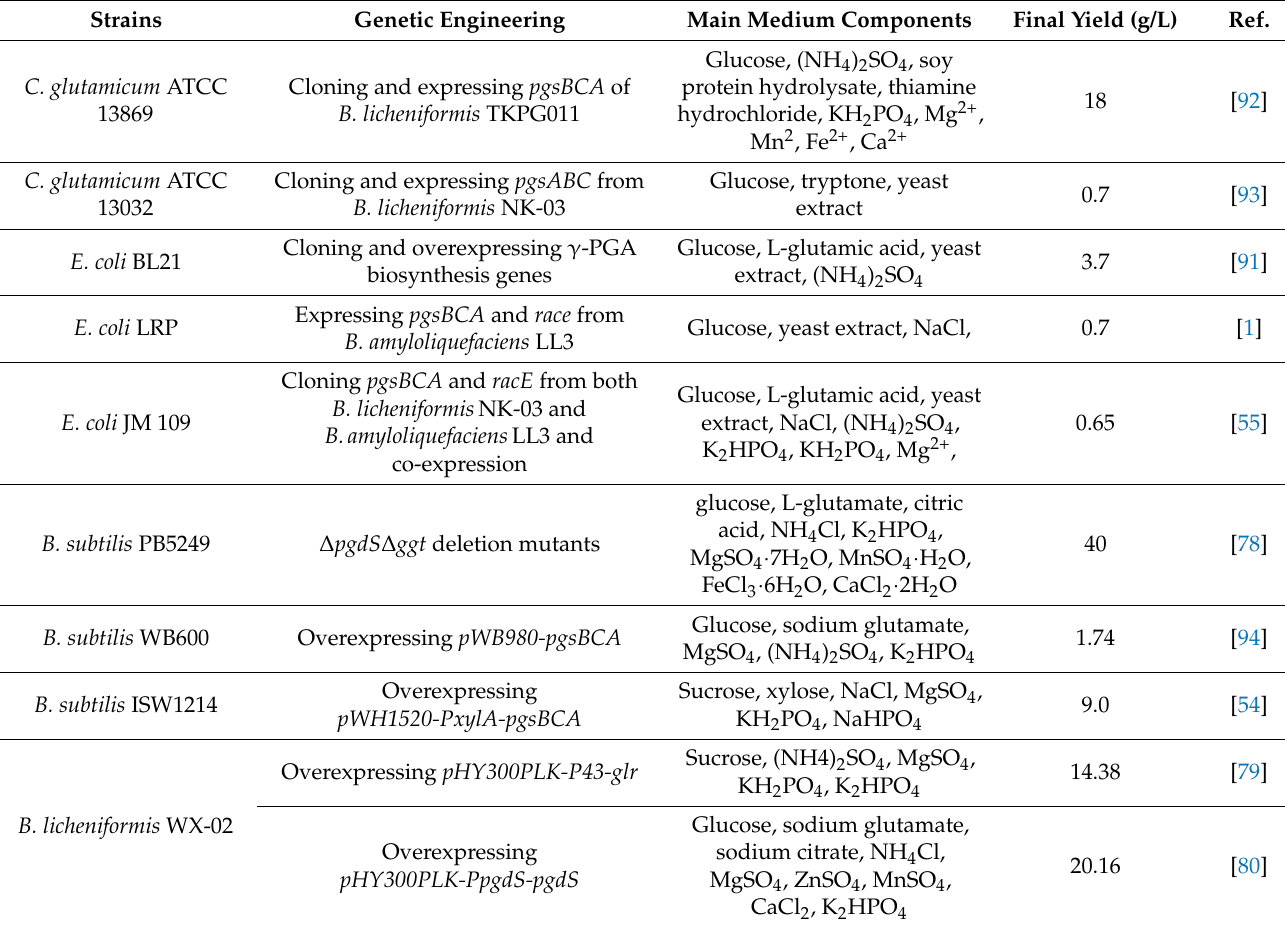
Table 3. Genetic manipulations of γ